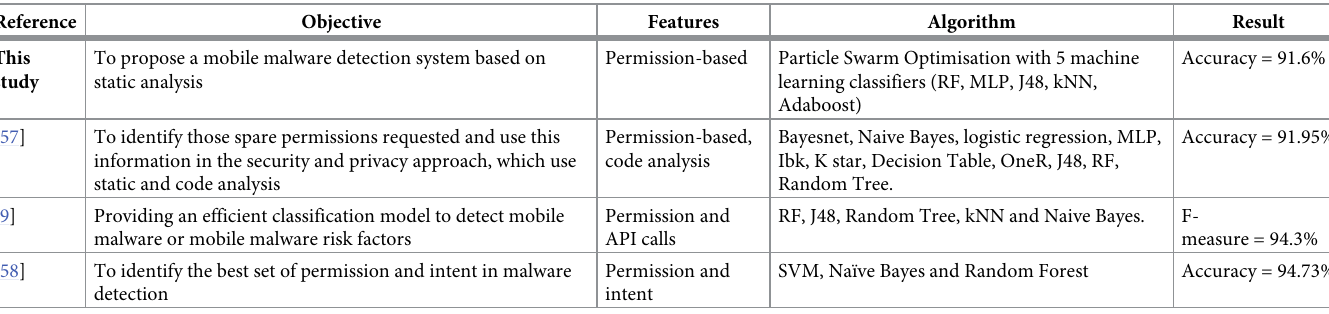
Table 11. Comparative study with related